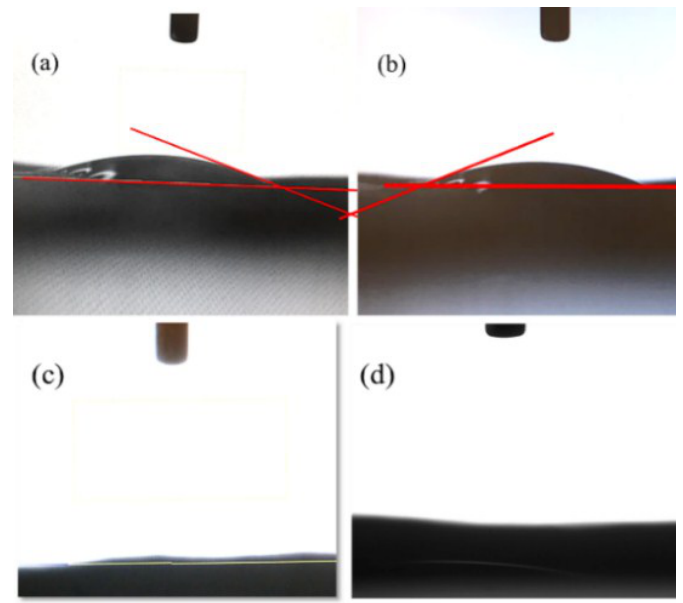
Figure 5. Water contact angle in air on different samples: ( a ) TiO 2 /GO/rTAC-p; and ( b ) TiO 2 /GO/rTAC-n; WCA in air after UV irradiation for 1 h: ( c ) TiO 2 /GO/rTAC-p; and ( d ) TiO 2 /GO/rTAC-n.